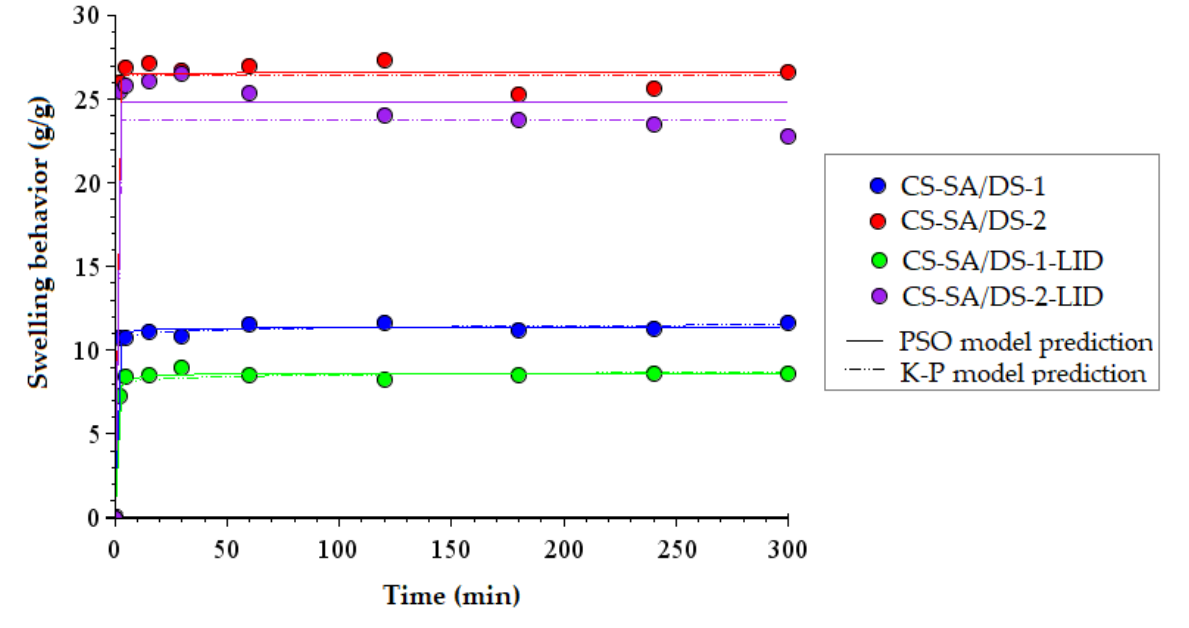
Figure 6. Swelling capacity of lidocaine-charged (CS-SA/DS-1-LID and CS-SA/DS-2-LID) and non- charged (CS-SA/DS-1 and CS-SA/DS-2) porous chitosan membranes, evaluated in PBS solution at 310 K. Experimental data were fitted with Pseudo-second order (PSO) and Korsmeyer–Peppas (K–P) kinetic models.